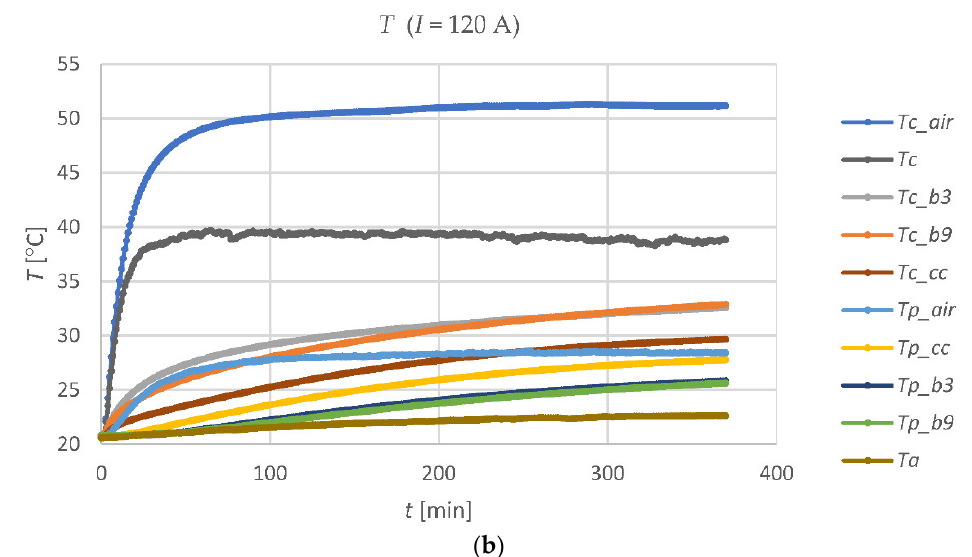
Figure 5. Temperature charts on the test stand: ( a ) with 60 A current in the cable; ( b ) with 120 A current.